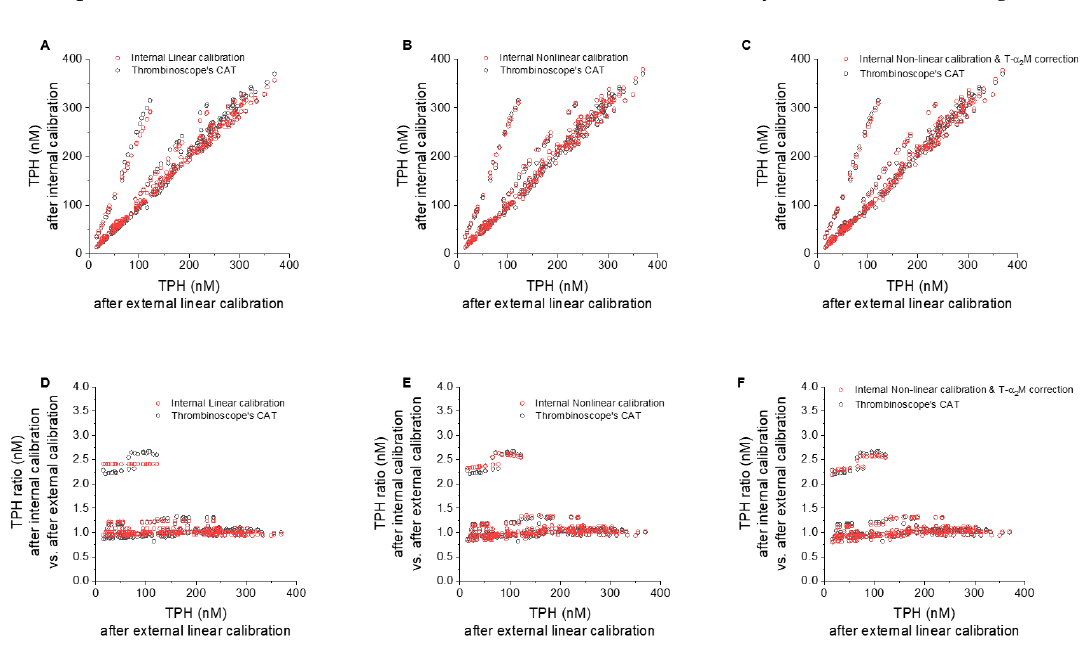
Figure 4. Effect of internal vs. external calibration algorithms on TPH values in PFP supplemented with coagulation factors and/or TM. Each dot represents a single experimental condition, as described in the legend for Figure 3. Red dots: analysis with our in-house software, black dots: analysis with commercial software (CAT-Thrombinoscope). ( A – C ) TPH after external linear calibration vs. ( A ) internal linear calibration, ( B ) internal non-linear calibration, and ( C ) internal non-linear calibration followed by T- α 2MG correction. ( D – F ) Normalized TPH (to external linear calibration) after ( D ) internal linear calibration, ( E ) internal non-linear calibration, and ( F ) internal non-linear calibration followed by T- α 2MG correction.